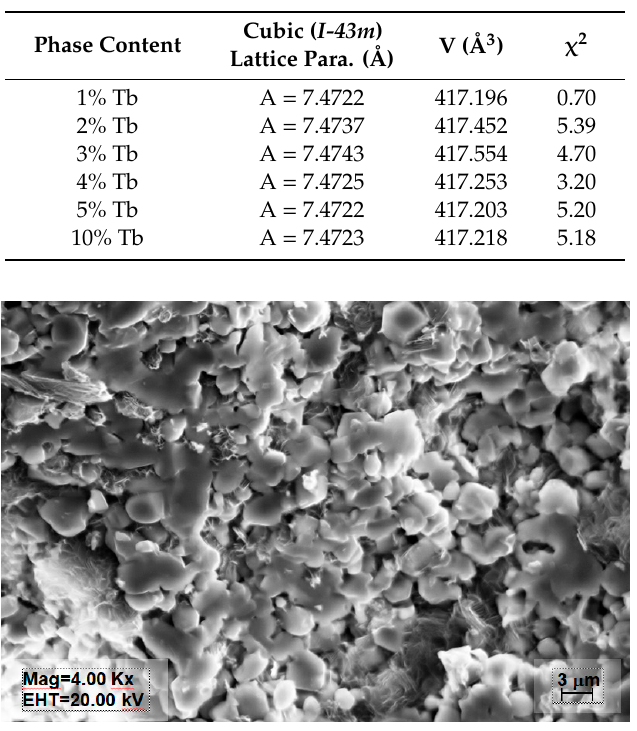
Table 1. The parameters calculated from the XRD patterns of ZnB 2 O 4 :Tb 3 + samples.